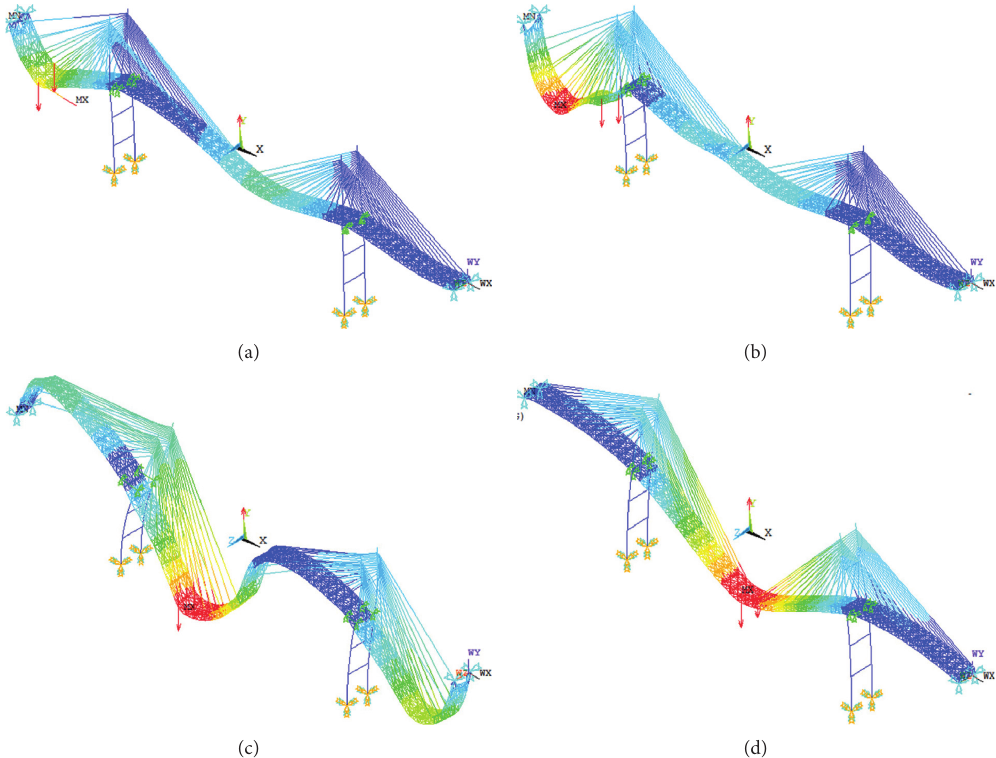
Figure 18: Collapse patterns of the bridge in different chord loss scenarios: (a) loss of chords A8-A9; (b) loss of chords A29-A30; (c) loss of chords A44-A45; (d) loss of chords A59-A58.